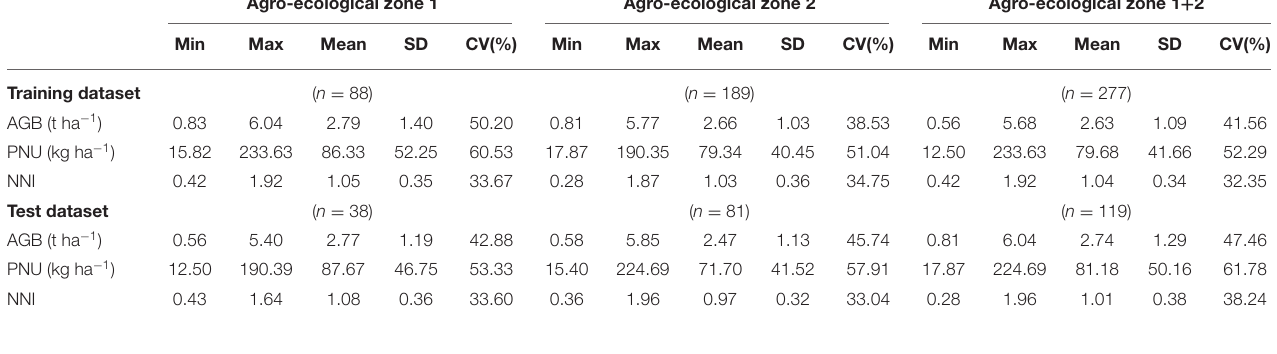
TABLE 2 | Descriptive statistics of winter wheat aboveground biomass (AGB), plant N uptake (PNU), and N nutrition index (NNI) for training and test dataset in different agro-ecological zones.